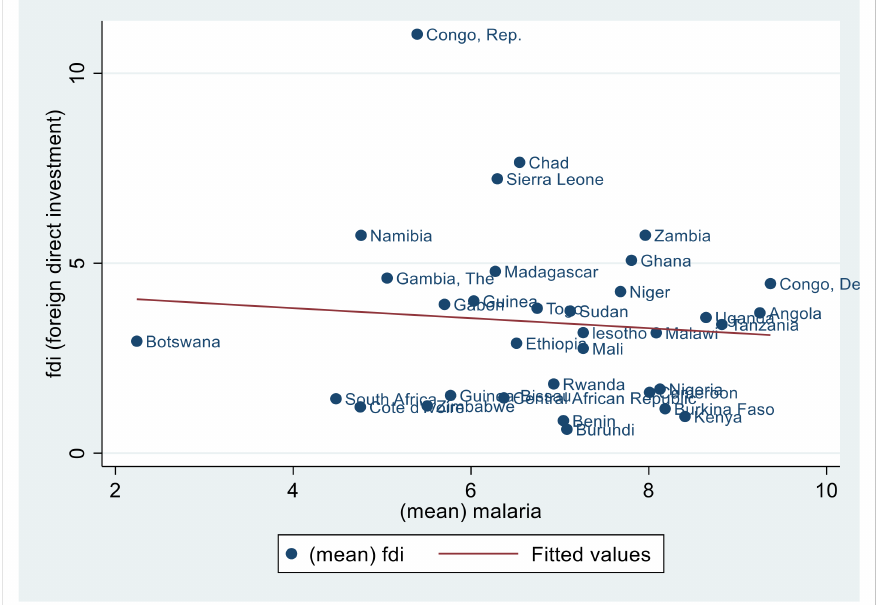
Figure 4. Malaria and FDI.